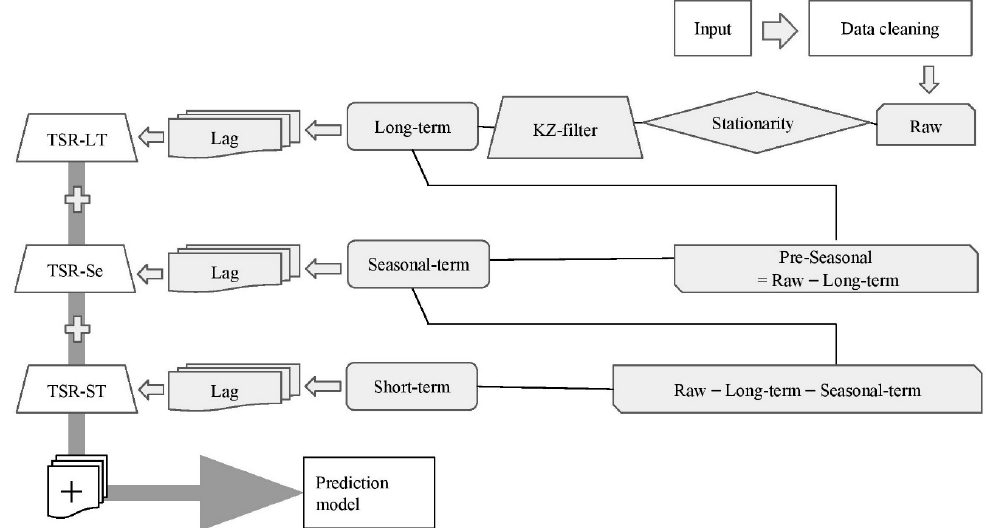
Figure 4. A flowchart displaying the steps of the methodology which includes the decomposition of the time series using the Kolmogorov-Zurbenko (KZ) filter, the lag operator, and the time series regression (TSR) model applied for each component (LT; long term, Se; seasonal term, ST; short term). The multiple linear regression model (MLR) follows a similar flow chart excluding the lag operator step.